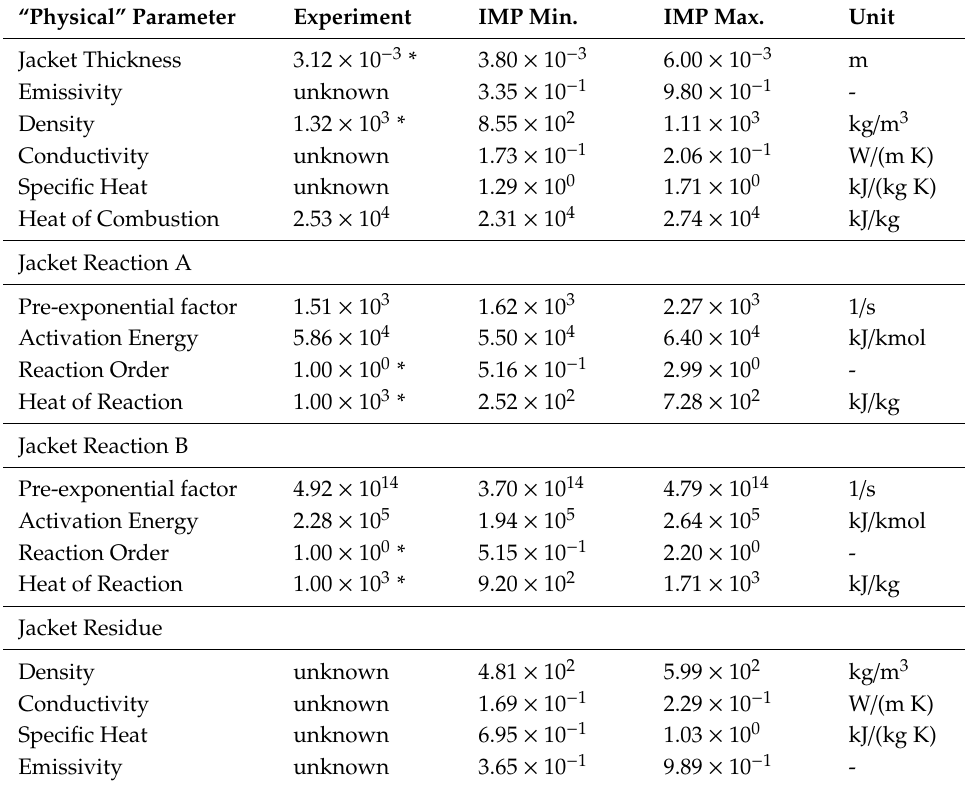
Table A2. Overview of the optimisation parameters of the IMP runs for the jacket. Data from the experiment is provided, if available. Layer thickness has been projected from a circular to a rectangular cross section to account for the layered representation in FDS. From the best parameter sets, over all IMP runs, the minimum (IMP Min.) and maximum (IMP Max.) values are provided. The parameter sequence is the same as for the ribbon plots, simply skipping parameters that are not used. (Note: values labelled with “*” are guessed and / or FDS